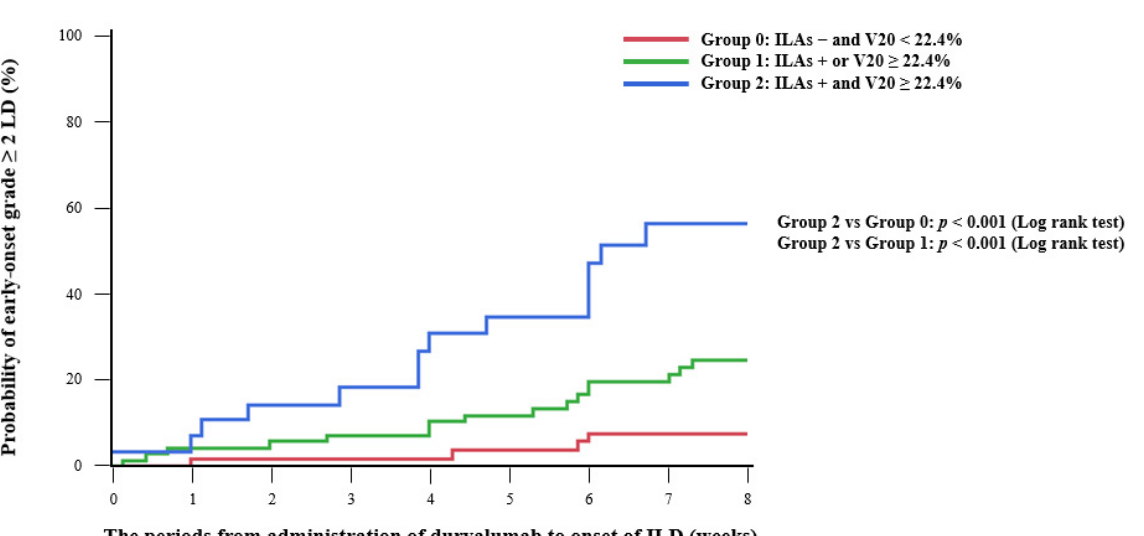
Figure 2. Incidence of early onset grade ≥ 2 ILD. Incidence of early onset grade ≥ 2 ILD in patients with ILAs and higher V20 was significantly higher than those with ILAs or higher V20 (42.9% vs. 13.4%, p = 0.0026) and those without ILAs and with lower V20 (42.9% vs. 3.8%, p < 0.001). ILAs, interstitial lung abnormalities; V20, volume of lung parenchyma that received ≥ 20 Gy; ILD, intersti- tial lung disease.